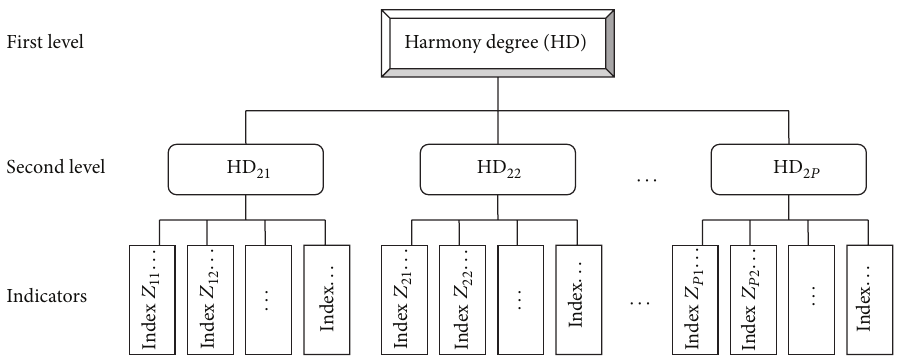
Figure 1: Multilevel harmony index system and harmony degree